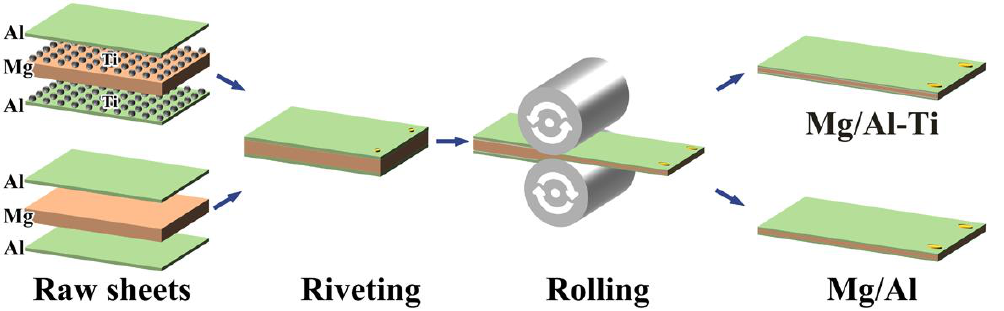
Figure 1. Schematic diagram showing the fabrication of composite sheets by hot rolling.